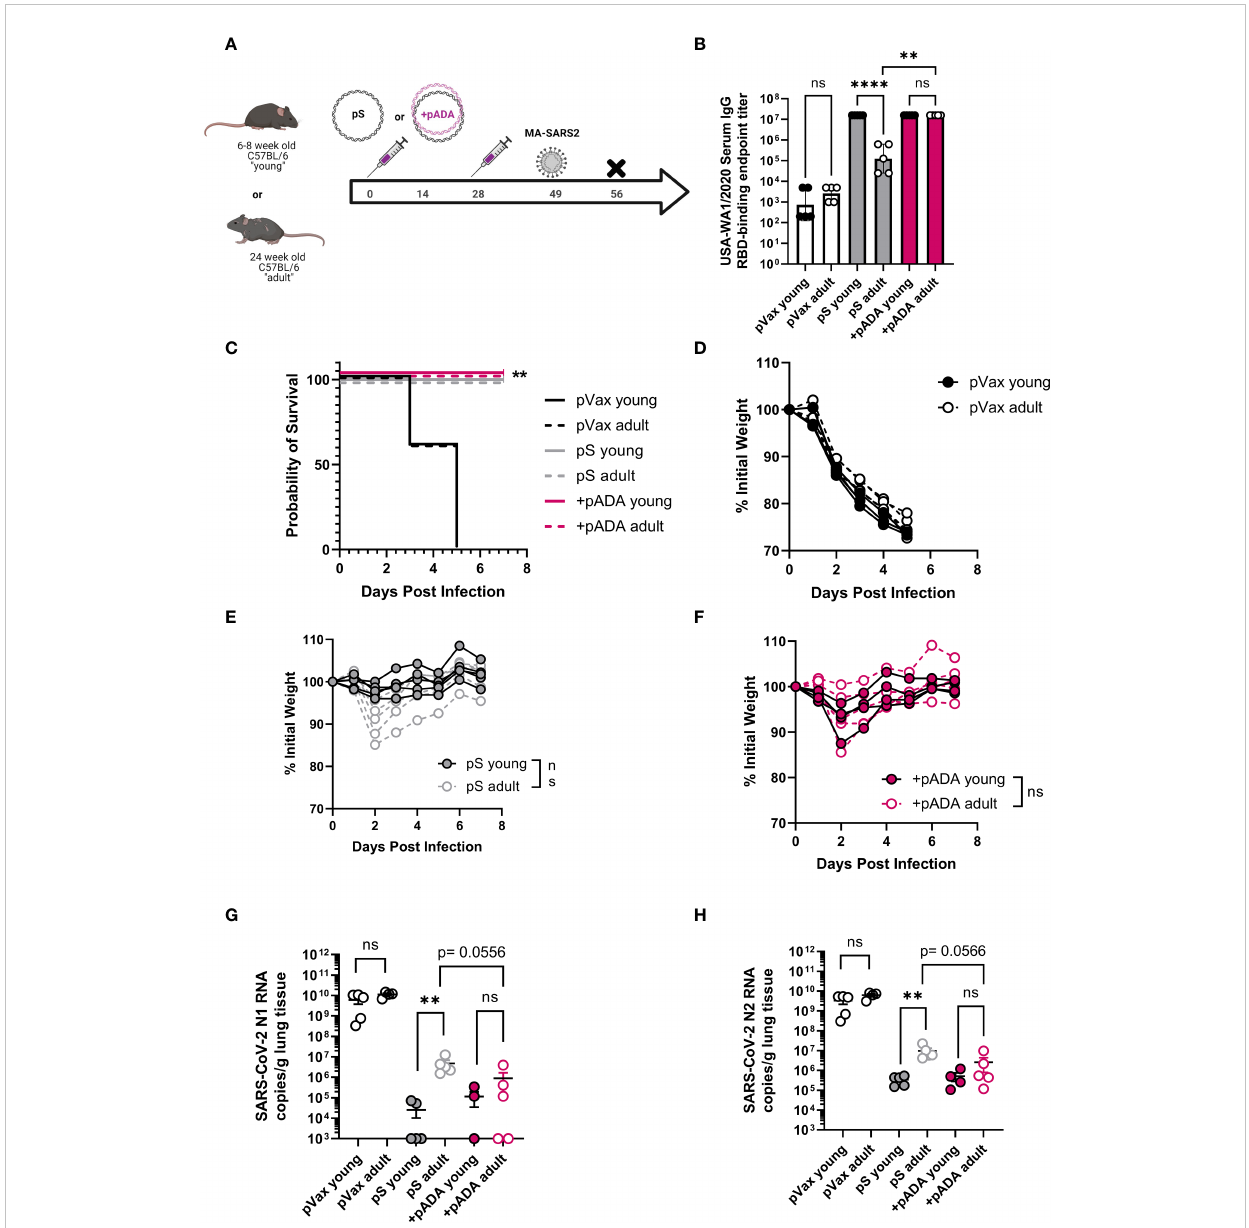
FIGURE 4 pADA enhances protection from mouse-adapted SARS-CoV-2 challenge in aged mice. Young (6-12 week-old, black circles), and adult (24-30 week-old, gray- fi lled circles) C57BL/6 mice were immunized twice as in Figure 2 and challenged with 1x10 5 plaque-forming units of mouse-adapted SARS-CoV-2 (MA-SAR2) on day 19 post-challenge and morbidity and mortality were monitored until day 7 post-challenge (A) . Parental SARS-CoV-2 (USA-WA1/2020) receptor-binding domain (RBD)-speci fi c IgG endpoint titers at day 10 post-2 nd immunization (B) . Survival curves for all animals (C) , and weight loss among empty plasmid immunized (pVax) (D) , pS-only immunized (E) , and pADA co-immunized (F) mice. SARS-CoV-2 nucleoprotein N1 (G) and N2 (H) RNA in the lungs of animals at day 7 post-challenge. Data are representative of a single experiment with N=5 (12 and 24 wk-old) and N=10 (66-68wk old) mice per group. Symbols represent the mean of duplicate (B) or triplicate (G, H) assays for individual animals, bars represent group mean and error bars represent the SEM. Symbols represent individual animals (C – F) . ns, not signi fi cant. **P<0.01 and ****P<0.0001 by Kruskall-Wallis ANOVA (C) or Mann-Whitney-U test between indicated groups (B, D – H)